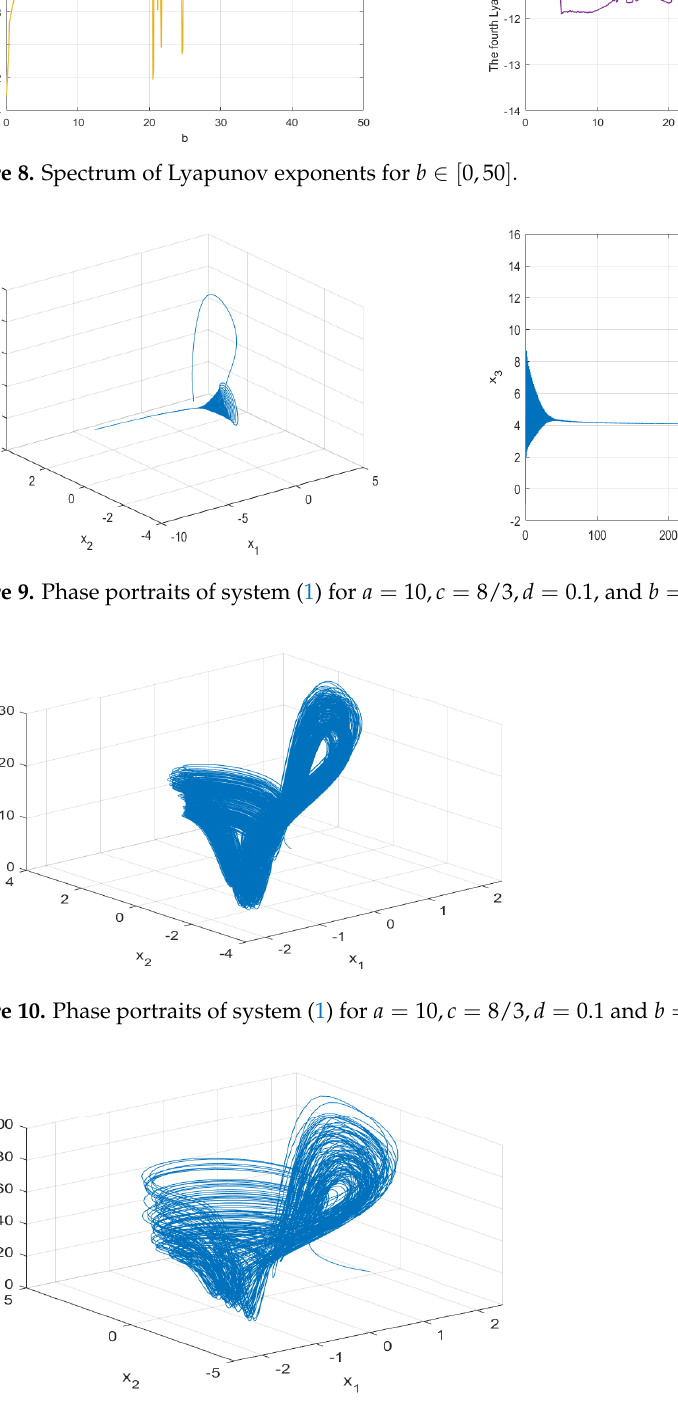
Figure 11. Phase portraits of system (1) for a = 10, c = 8/3, d = 0.1, and b =